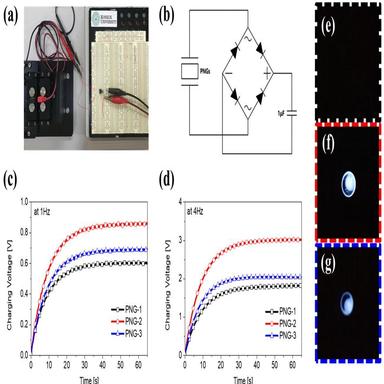
A Photograph of the energy storage system (a), the charging circuit diagram (b), and the charged voltage curves at 1 Hz (c) and at 4 Hz (d) of 1 μF capacitor. The snapshots of white LEDs driven by PNG-1 (e), PNG-2 (f), and PNG-3 (g).